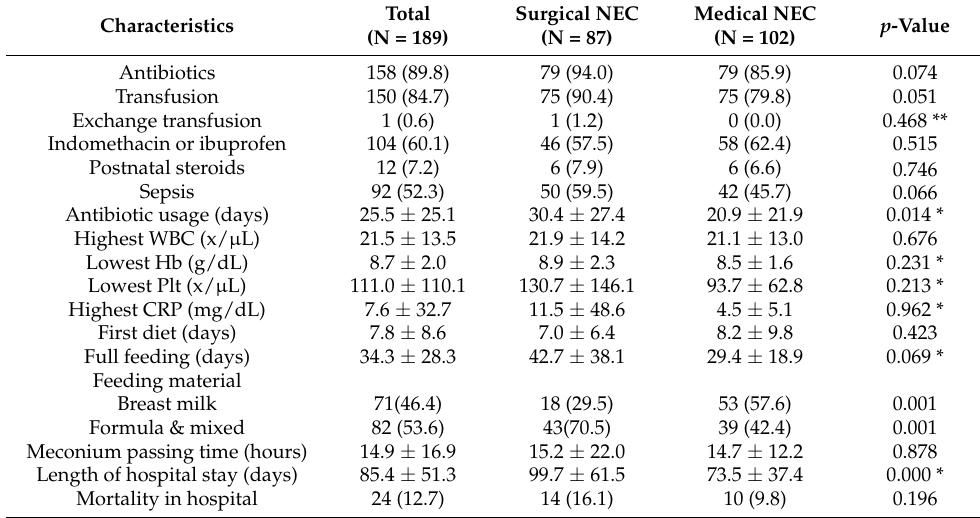
Table 3. Laboratory and treatment